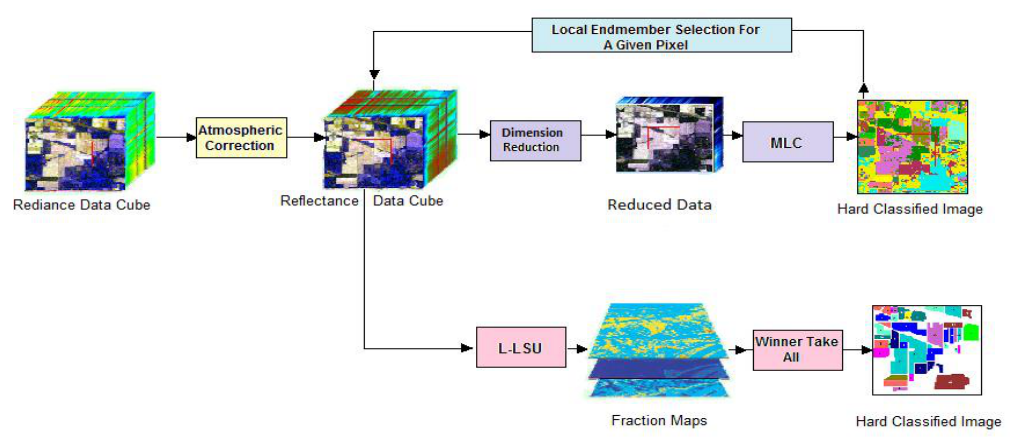
Figure. 2. The end-to-end Local Linear Spectral Unmixing algorithm